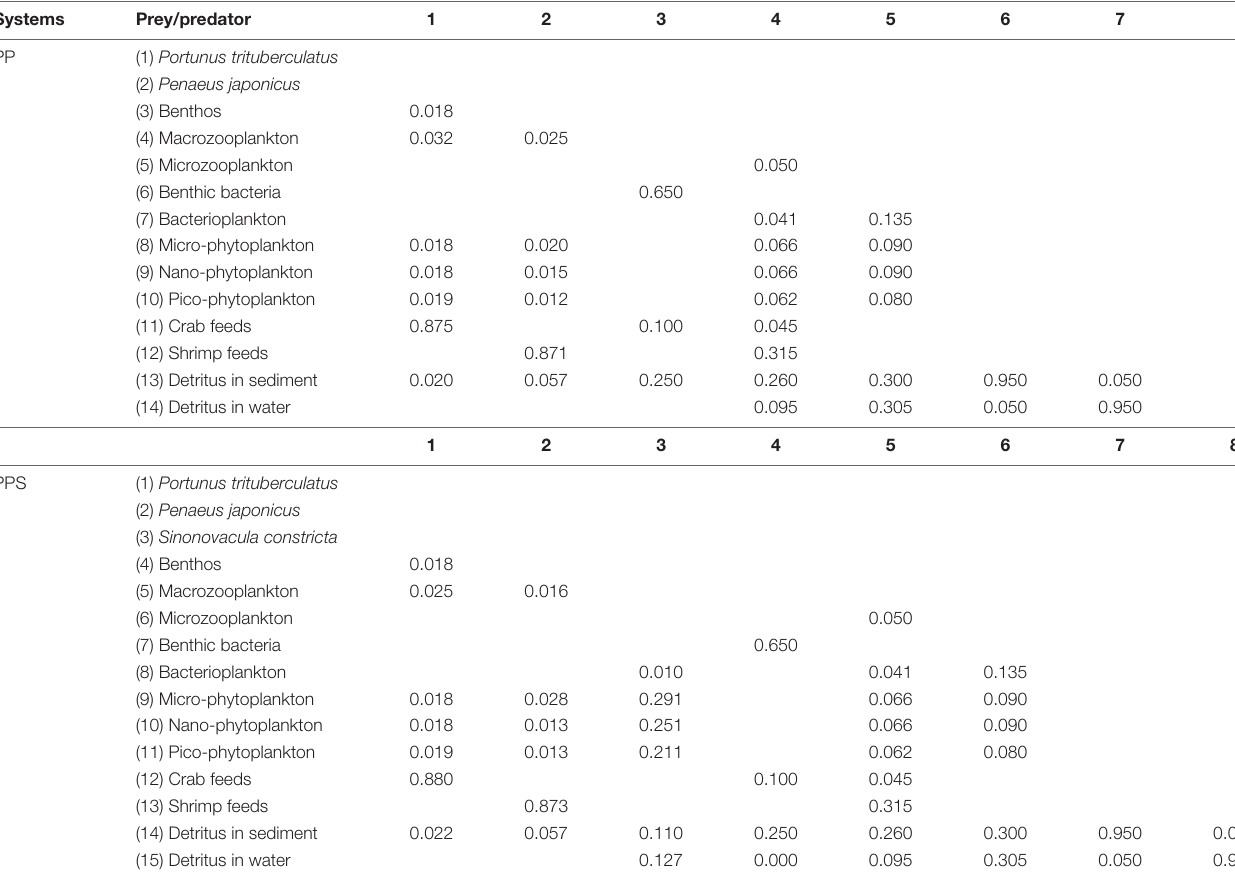
TABLE 3 | Diet matrix of the two integrated pond aquaculture ecosystems. Systems